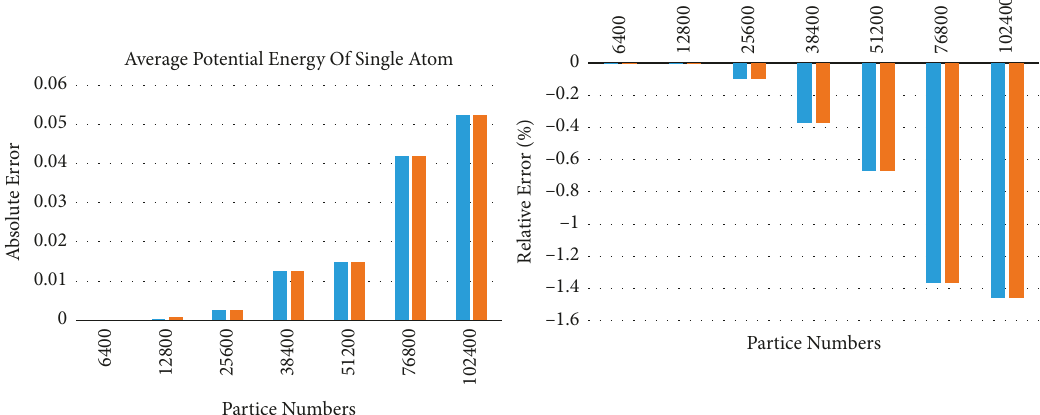
Figure 10: Error analysis of the GPU algorithm relative to the CPU algorithm for single-atom average potential energy